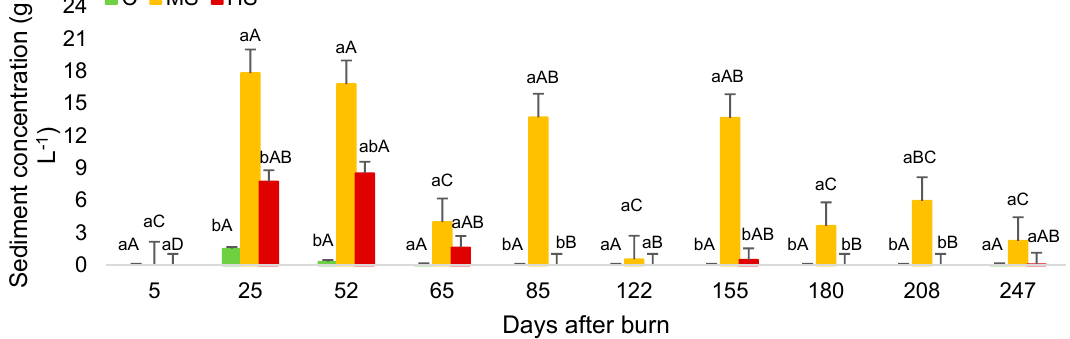
Figure 4. Treatment e ff ect under control (C), moderate severity (MS), and high severity (HS) burn on sediment concentration (g L − 1 ) between 5 and 247 days after pile burning. Mean values followed by the different lowercase letters show significant differences within the same date. Mean values followed by the different uppercase letters show significantly different within the same treatment. Significant differences were observed at p < 0.05 . Hanging bars represent the standard error. ( n = 5).